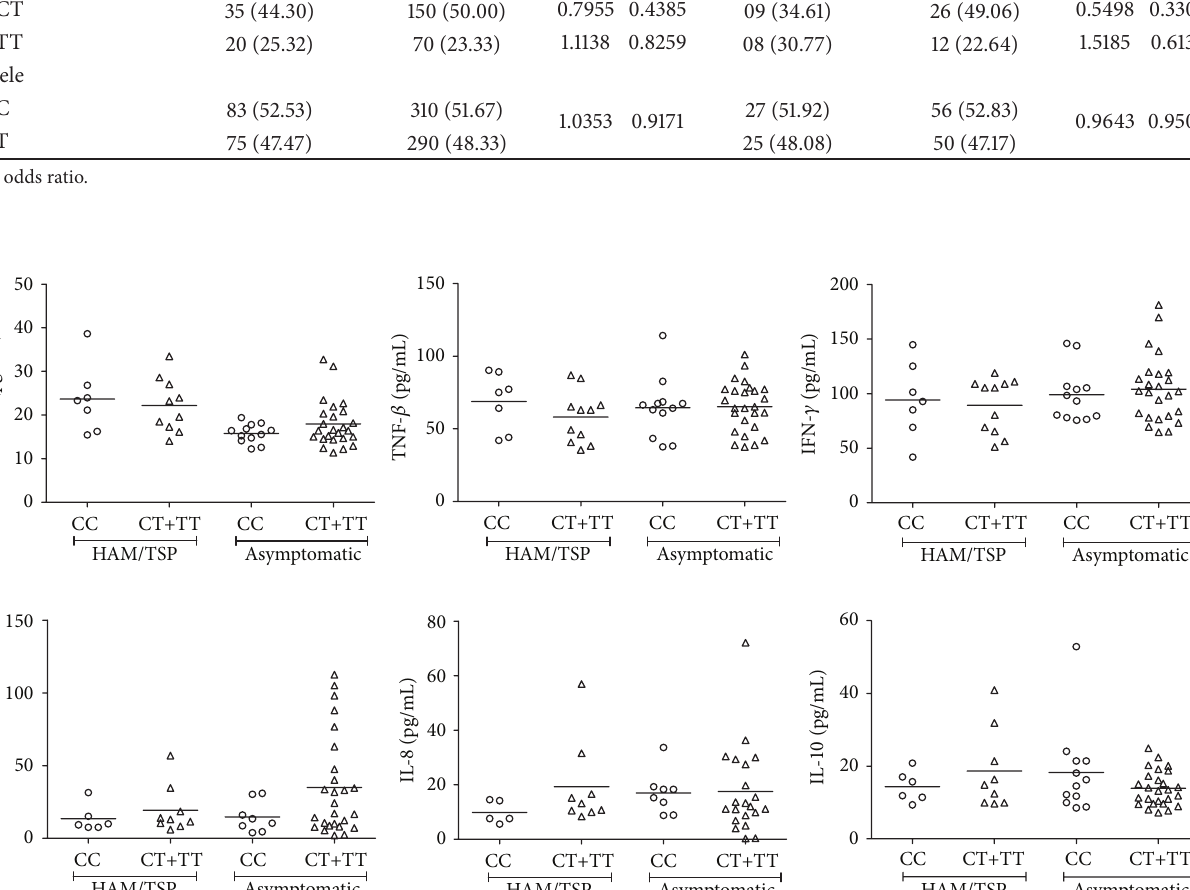
related to susceptibility or resistance to HTLV-1 infection or to the clinical prognosis of the